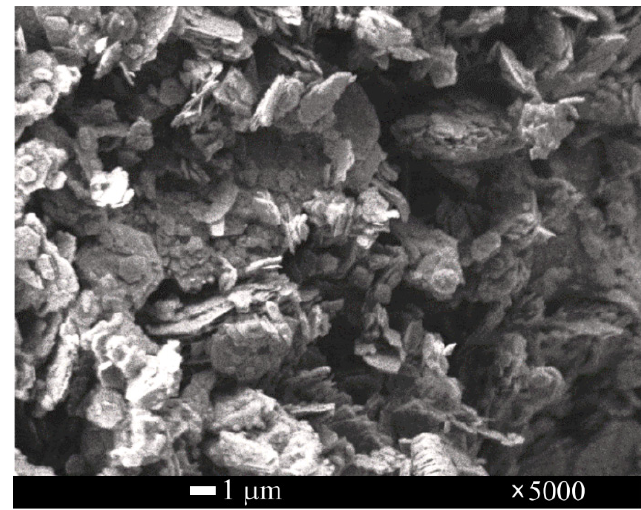
Figure 4. SEM image of the MKA zoomed in 5000 times.